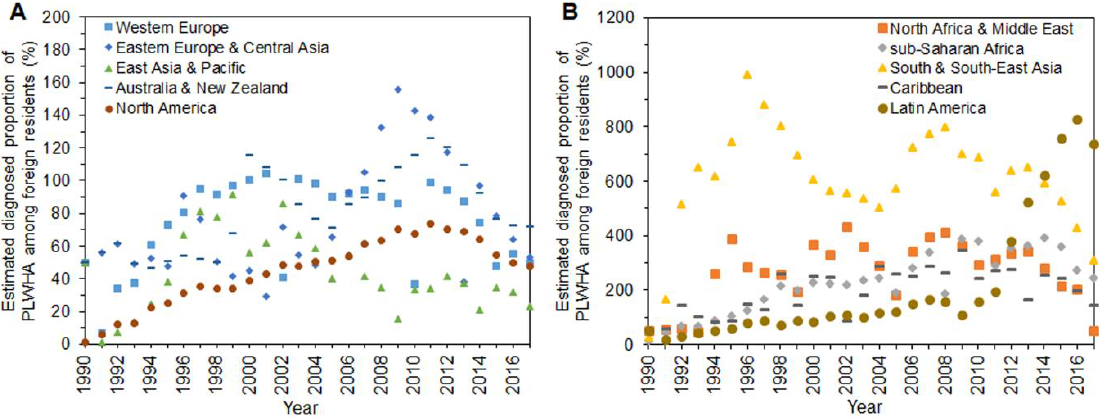
Figure 2. Estimated diagnosed proportion of human immunodeficiency virus (HIV) infections among foreign residents in Japan, 1990–2017. Estimates of the proportion of diagnosed infections out of the cumulative number of HIV infections and acquired immunodeficiency syndrome (AIDS) cases. Two panels are shown because of varying estimates. ( A ) People from Western Europe, Eastern Europe and Central Asia, East Asia and Pacific, Australia and New Zealand, and North America. ( B ) People from North Africa and Middle East, sub-Saharan Africa, South and South-East Asia, Caribbean, and Latin America.